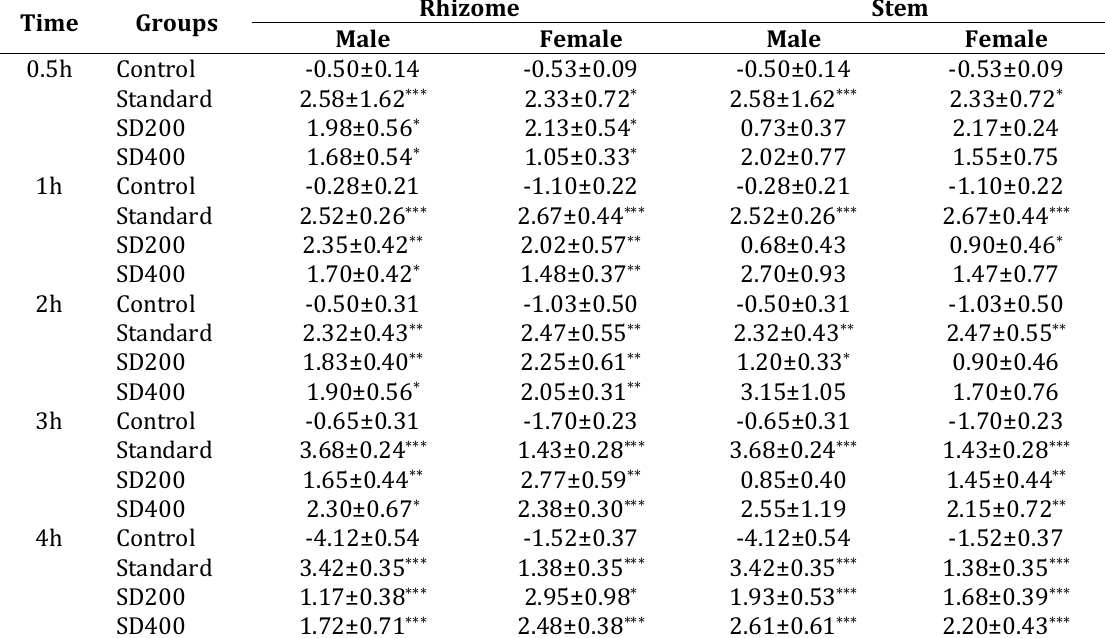
Table II. Reduction in body temperatures (°F) in male and female mice in yeast induced febrile condition after administration of rhizome and stem extracts